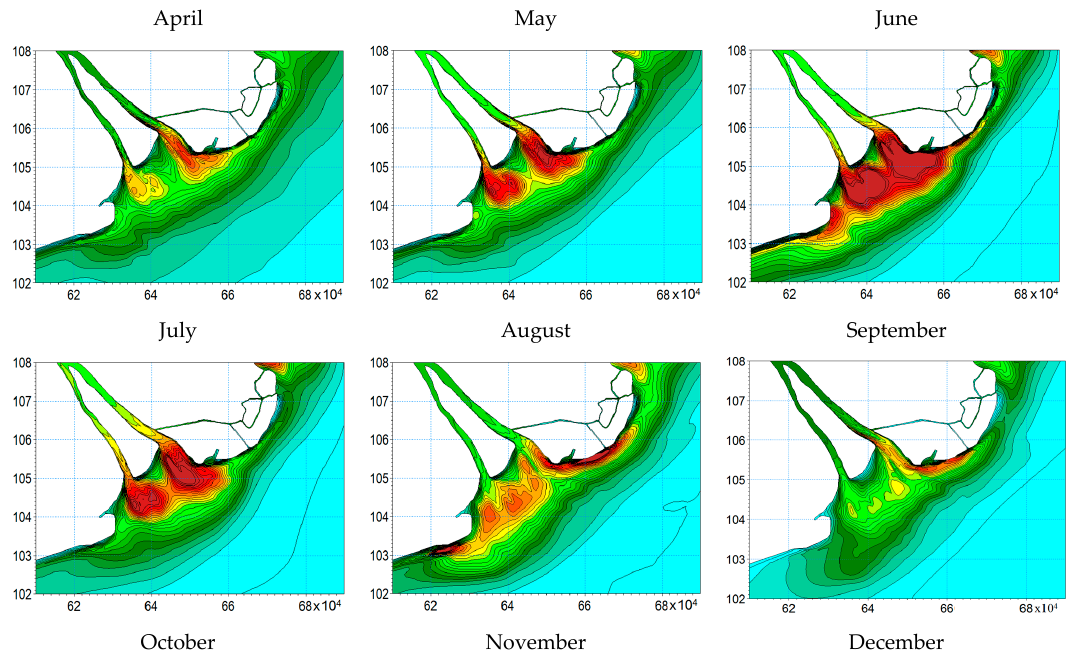
Figure 19. Spatial distribution of monthly mean SSC in the bottom layer. Color scale is the same as in Figure 8.